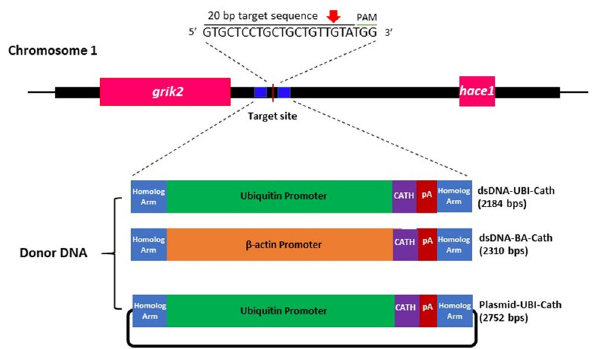
Figure 1. Schematic representation of the target site and the surrounding genome in chromosome 1 of channel catfish ( Ictalurus punctatus ) genome where insertion of the transgene was made. The 20-bp guide RNA sequence containing the PAM was shown and the cut site (red arrow) which aided the targeted insertion of the donor DNA constructs: double-stranded DNA (dsDNA) driven by zebrafish ubiquitin promoter (dsDNA-UBI- Cath), dsDNA driven by carp β-actin promoter (dsDNA-BA-Cath) and plasmid DNA, pUCIDT with zebrafish ubiquitin promoter (plasmid-UBI-Cath). Grik2 is 1376 bp upstream of the target and hace1 is 295,702 bp downstream of the